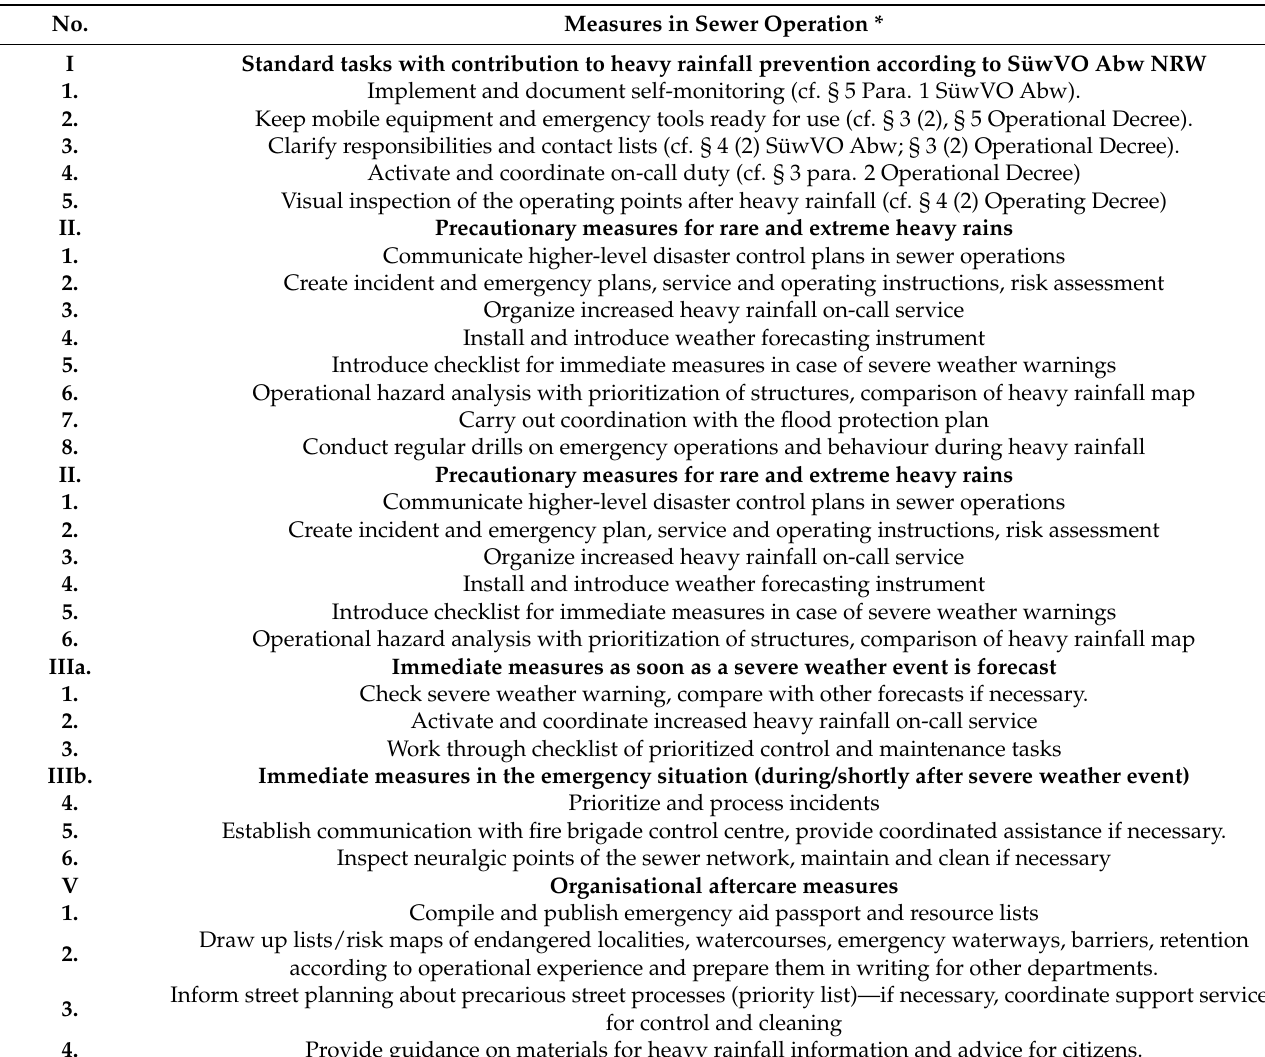
Table 3. Dealing with heavy rainfall—overview of essential measures in sewer